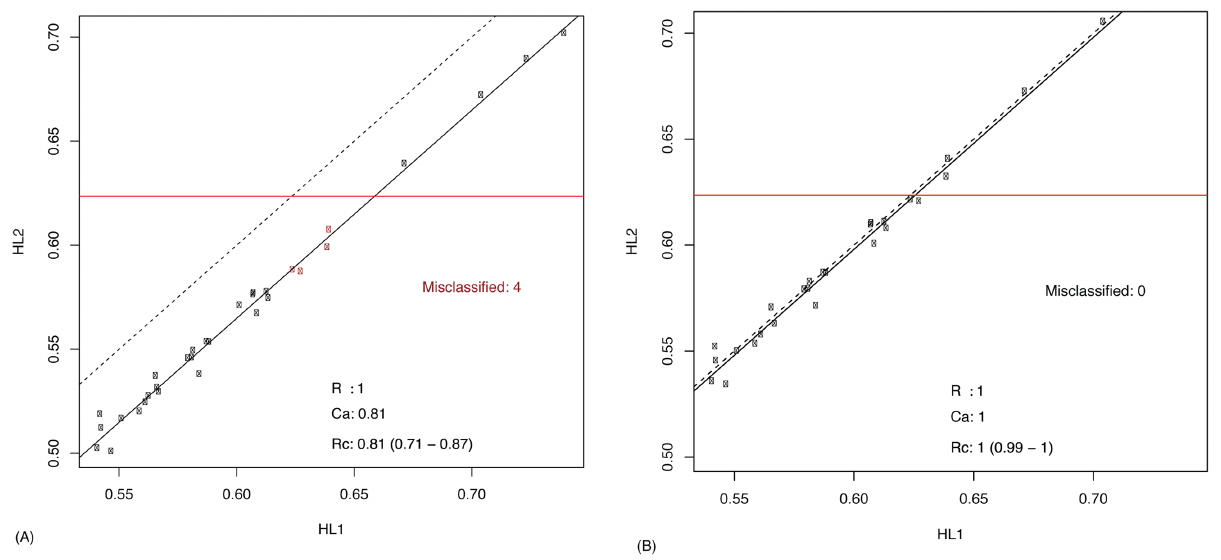
Fig 7. Impact of BE on downstream analysis, illustrated using a HL prognostic model. The x and y axes correspond to risk scores obtained in HL1 and HL2 respectively. The dashed line represents the identity line, and the solid line represents the best linear fit. The horizontal line indicates the threshold used for prediction. The results in (A) correspond to scores not corrected for BE, and in (B) scores are corrected using 3 reference samples that were run in both